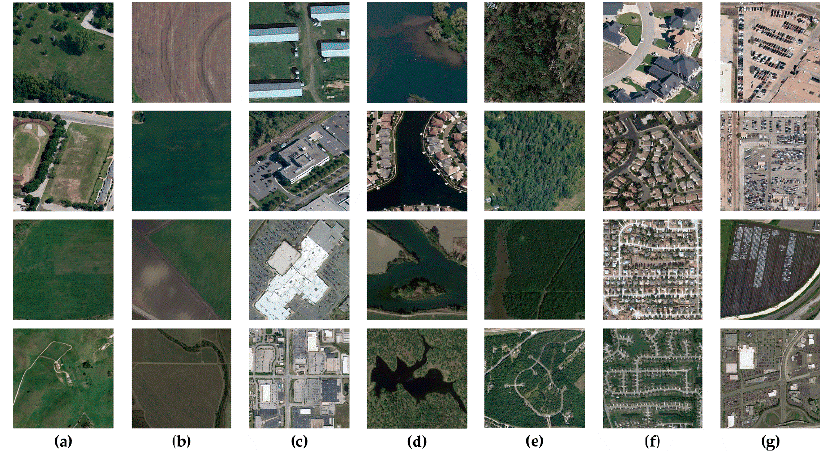
Figure 5. Sample images from the RSSCN7 database: ( a ) grassland; ( b ) farmland; ( c ) industrial and commercial regions; ( d ) river and lake; ( e ) forest field; ( f ) residential region; ( g ) parking lot. There are four scales, from top to bottom (in rows): 1:700, 1:1300, 1:2600, and 1:5200.